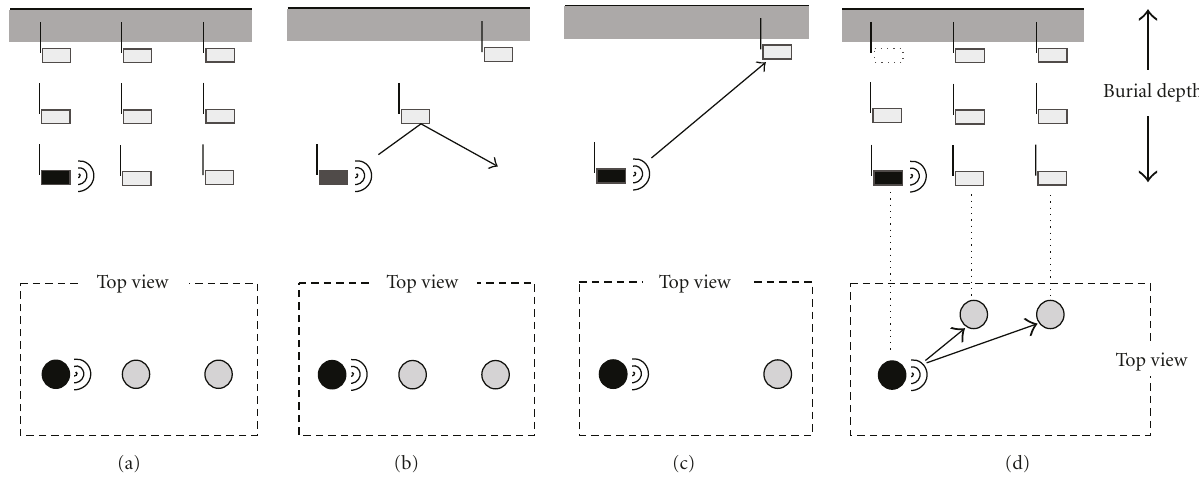
Figure 2: (a) The grid concept used to speed up the experiments in a WUSN testbed. (b) A case, where the grid can interfere with the results. (c) Ideal case for experiments and (d) an alternate grid